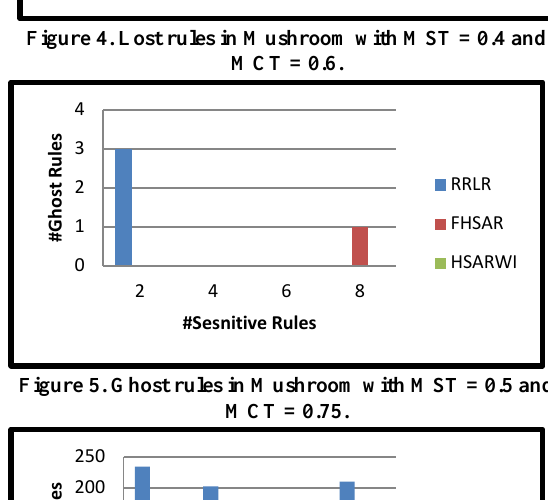
Figure 5. Ghost rules in Mushroom with MST = 0.5 and MCT = 0.75.